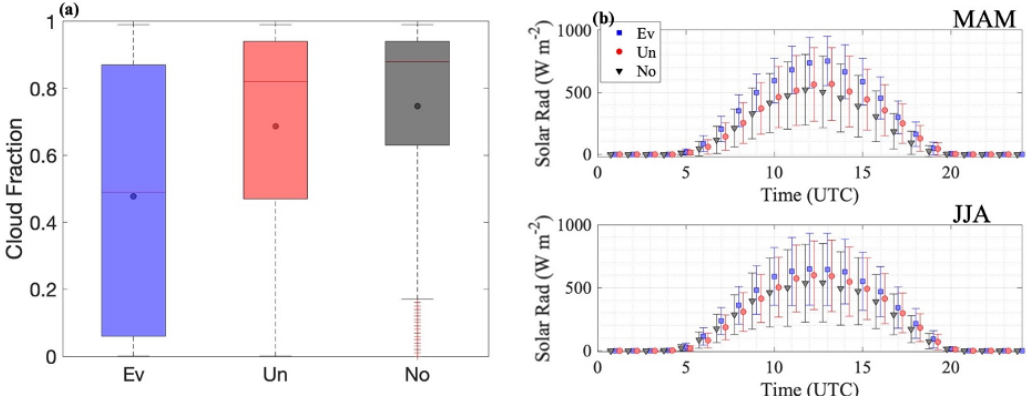
Figure 6. (a) Cloud fraction observed from 09:00 to 14:00UTC during event (Ev), undefined (Un), and non-event (No) days. The red line represents the median and the circles the average, while the lower and upper edges of the box represent the 25th and 75th percentiles, respectively. The lower and upper edges of the whisker correspond to the 10th and 90th percentiles, respectively. (b) Diel variations (UTC) of the mean total solar radiation observed during the event days (Ev, blue squares), undefined days (Un, red dots), and non-event days (No, black triangles) during spring (MAM, top) and summer (JJA, bottom) seasons (b) . The error bars correspond to one standard deviation.